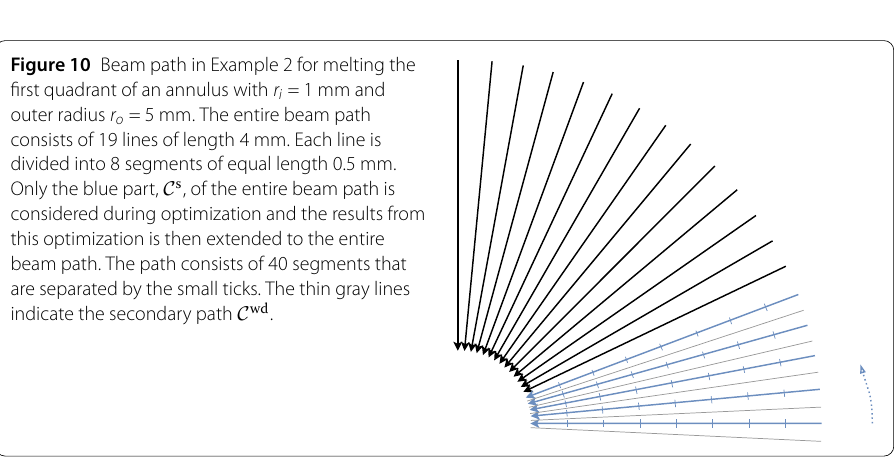
Figure 9 A comparison between maximum temperatures in the cross-section y = 2 l off = 0.4 mm (i.e., along the 3rd hatch line) before optimization (top) and after optimization. The depth of the melt area is reduced and made more uniform. The domain is scaled by a factor 10 in the vertical direction.